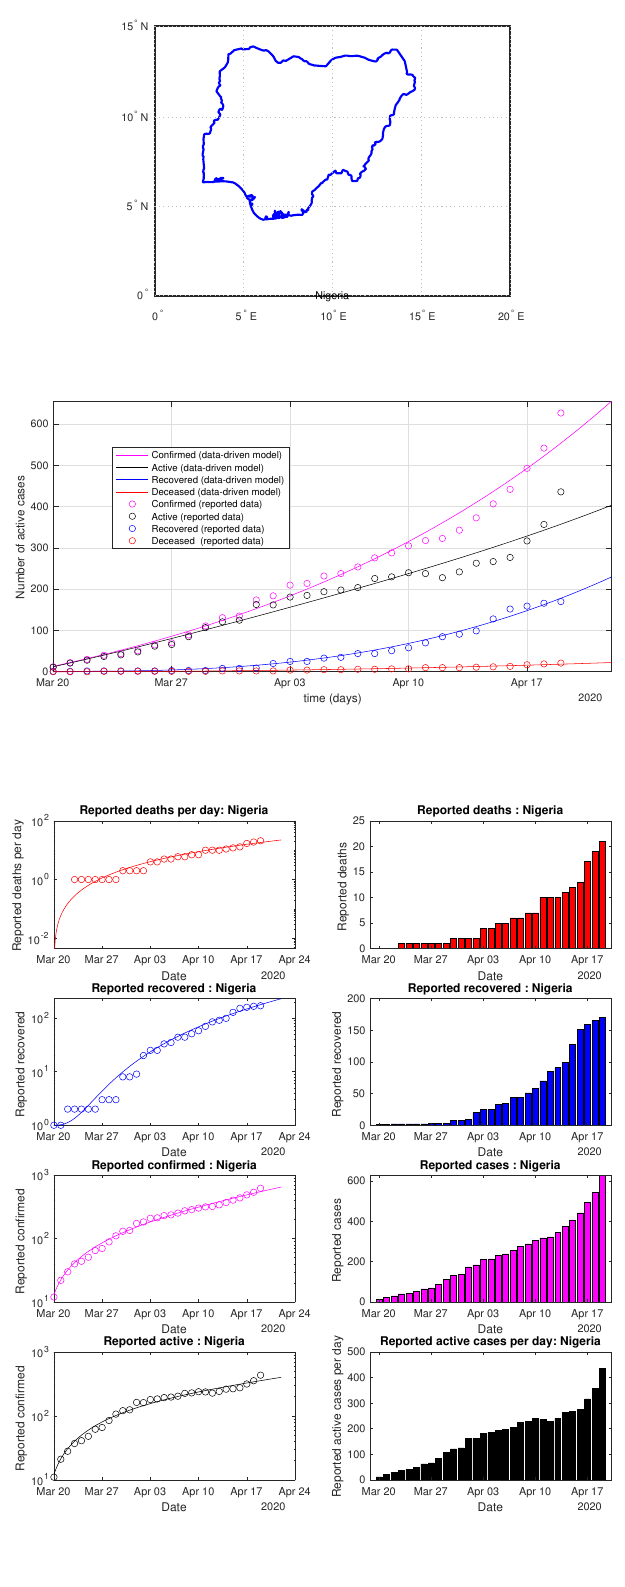
Figure 79. Nigeria: data vs.